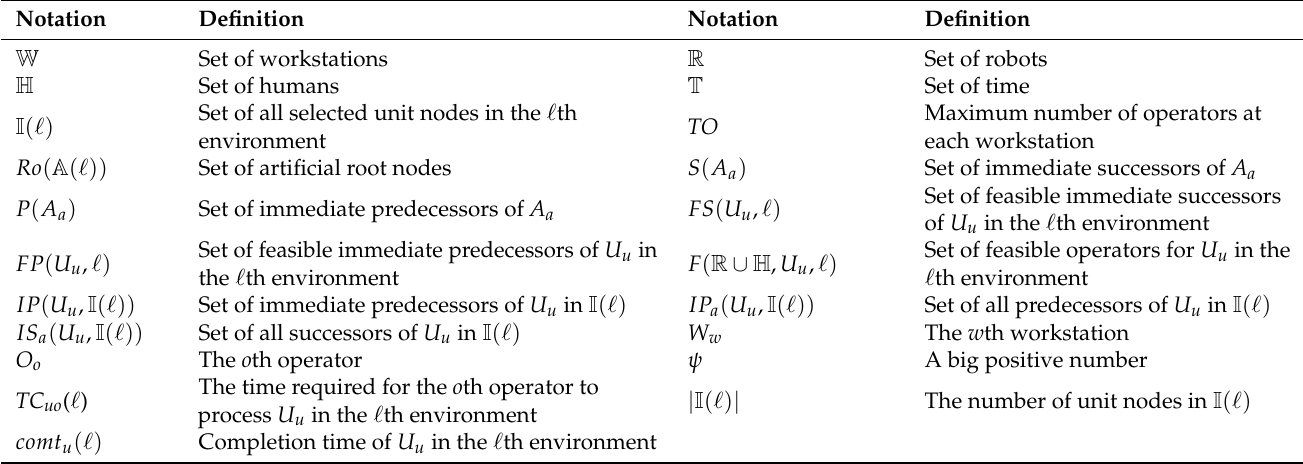
Table 2. The sets and parameters used in the model.